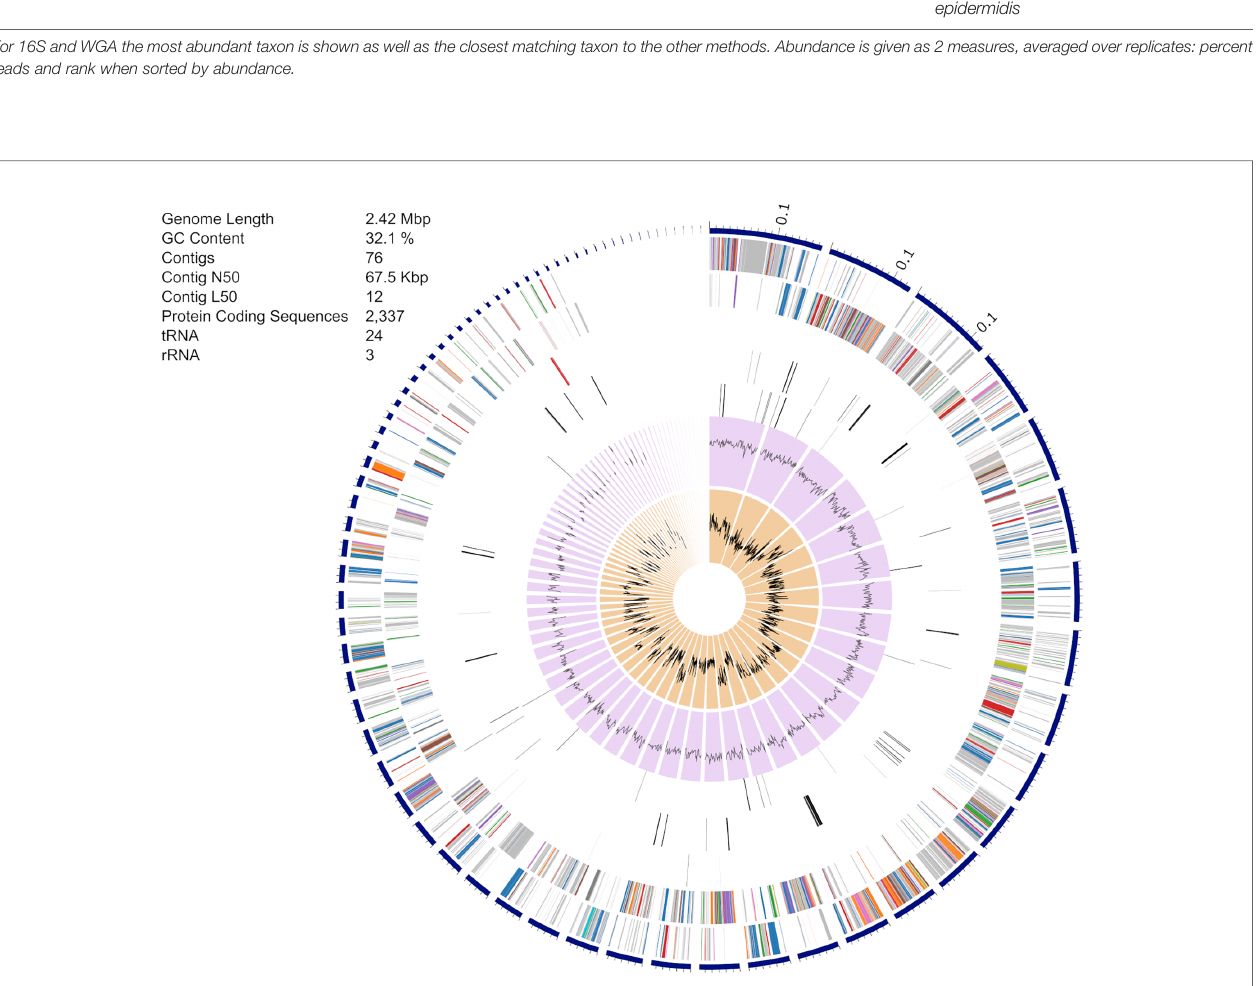
FIGURE 3 | Assembly of the S. epidermidis CLIMB1 genome. The circular display of the assembly shows, from outer to inner rings, the contigs, coding sequences on the forward strand, coding sequences on the reverse strand, RNA genes, coding sequences of putative antimicrobial resistance genes, coding sequences of